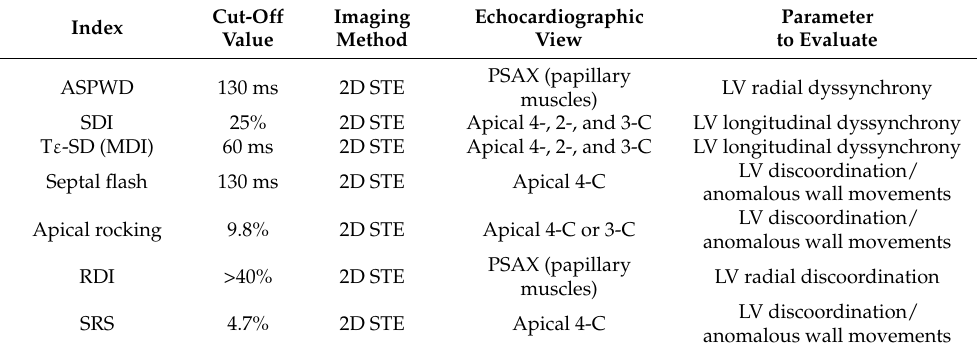
Table 2. Some of the new ultrasound technologies-derived measures for evaluation of LV mechanical dyssynchrony and